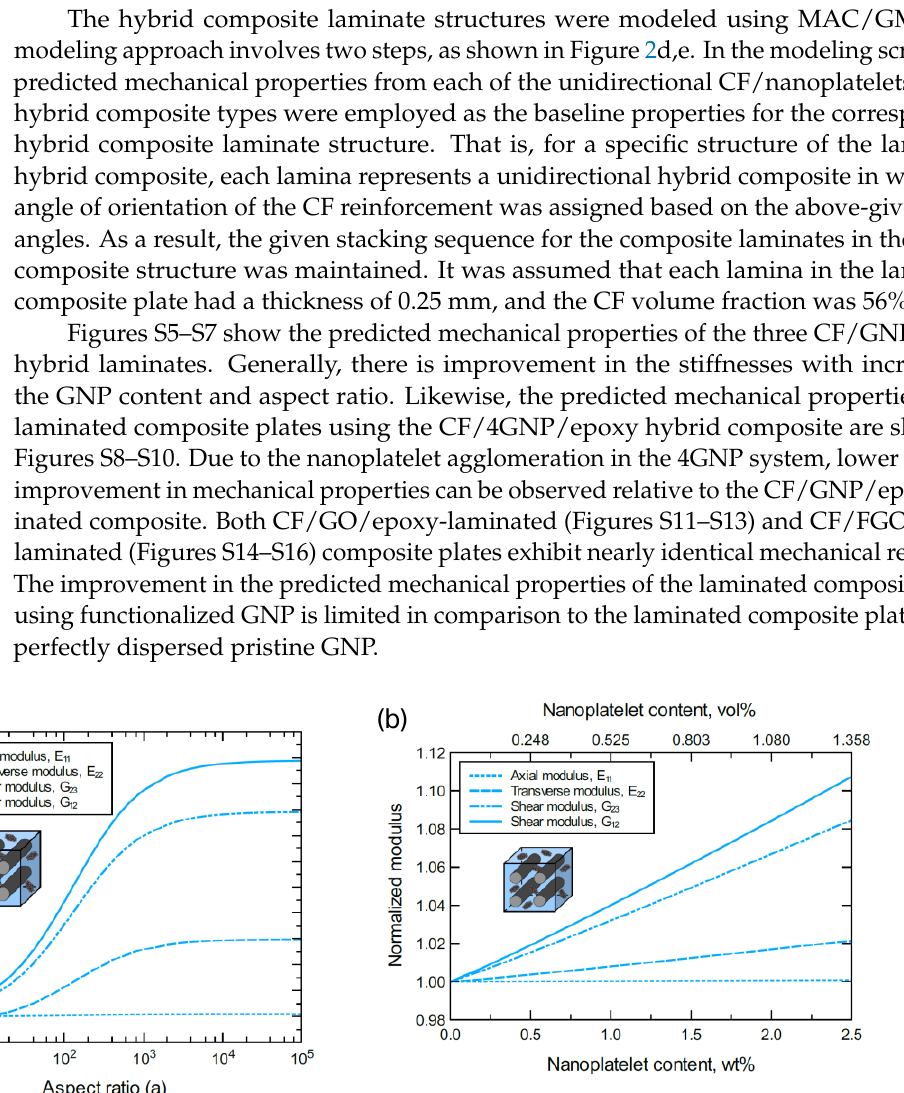
Figure 10. Normalized elastic and shear moduli for unidirectional CF/FGO/epoxy ( a ) at 1.0 wt% FGO content and various FGO aspect ratios, ( b ) at 10 3 FGO aspect ratio and various FGO contents. The volume fraction of CF is 56%.